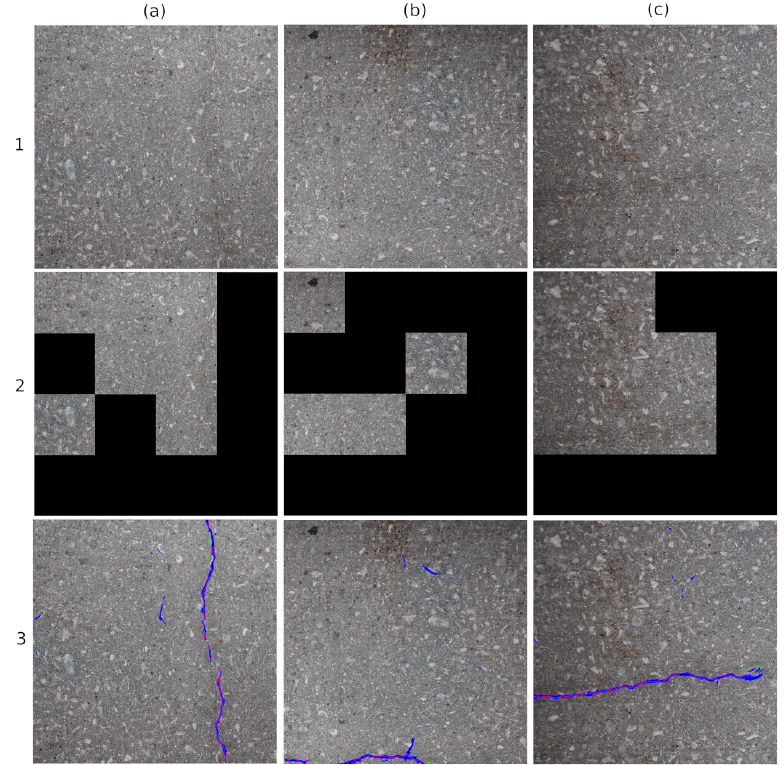
Figure 11. Comparison of image classification architectures with encoder-decoder architecture on three sample images. Columns are the tested images: ( a ) contains clear vertical crack, ( b ) contains small crack on bottom, ( c ) contains a crack at arbitrary orientation. Row 1—original image; Row 2—Gibbs architecture [3]; Row 3—ANet-FSM